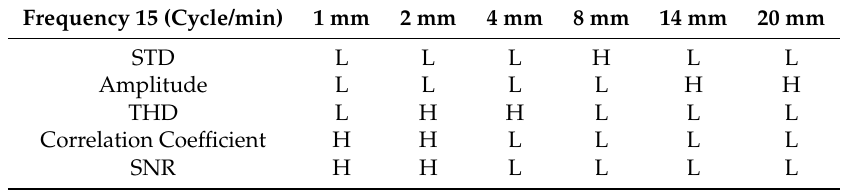
Table A13. Values higher and lower than the median Frequency 15 cycles/min for a 5 mm band.